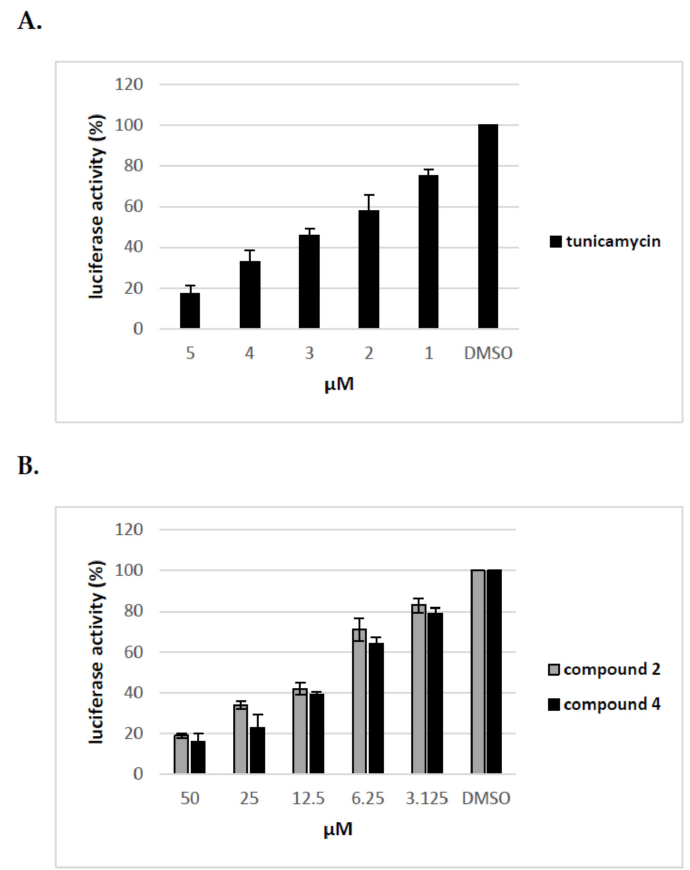
Figure 6. The effect of tunicamycin and uridine derivatives of 2 ‐ deoxy sugars on HCVpp secretion and/or infectivity. HEK ‐ 293 T cells were transfected with three plasmids to produce HCVpp. 16 h p.t. fresh medium with different doses of tunicamycin ( A ) or compounds 2 and 4 ( B ) were added. Cell culture supernatants containing pseudoparticles were harvested 48 h post transfection and used to infect overnight Huh ‐ 7.5 cells. Infection efficiency after 72 h was measured by luciferase assay. The infectivity of HCVpp produced in DMSO ‐ treated cells are expressed as 100%. Error bars indicate